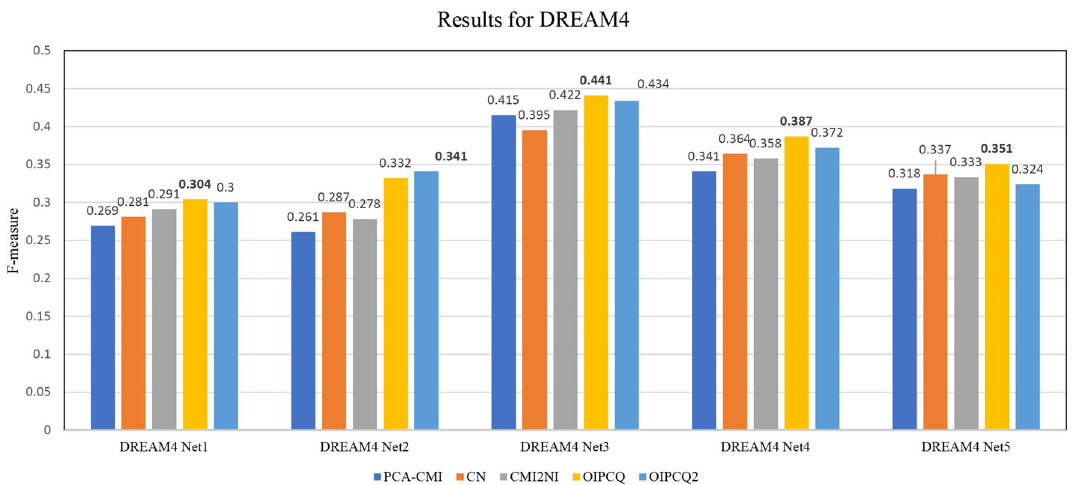
Figure 2. Comparison of F-measure values of OIPCQ and OIPCQ2 algorithms with other methods for learning DREAM4 challenge for five networks of the 100-multifactorial